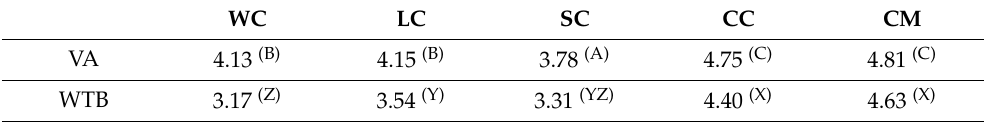
Table 2. Means of the answers were obtained according to Visual Acceptance (VA) and Willing to Buy (WTB) for each cake.